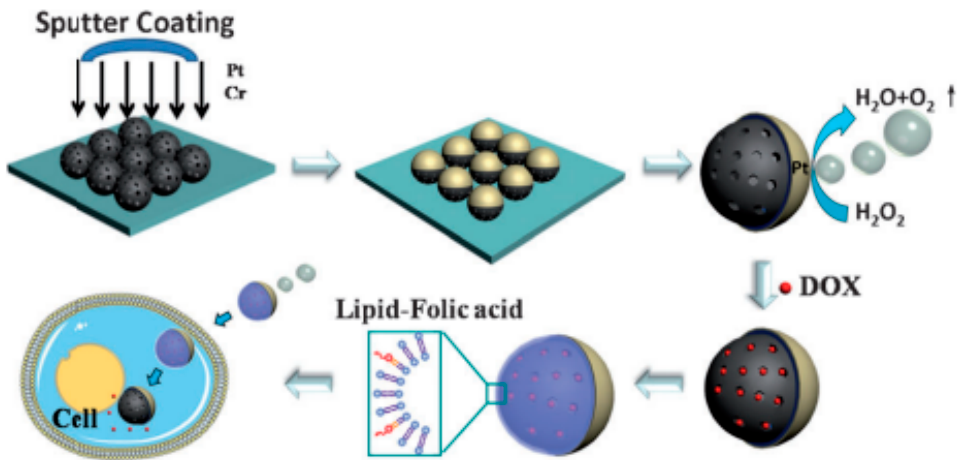
Figure 18. Janus micromotor with one hemisphere coated with Pt and the other hemisphere coated with biotin for specific drug delivery. Reproduced with permission from [245].